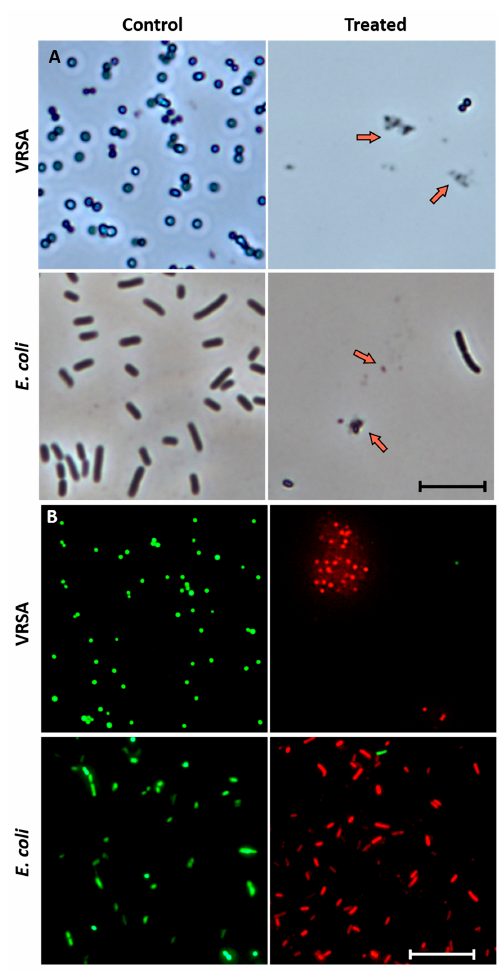
Figure 5. ( A ) The phase contrast microscopic images of VRSA and E. coli, with orange arrows showing the dead cells with cell debris. Scale is 5 µm. ( B ) The live/dead cell images of VRSA and E. coli, where cells stained with SYTO9 are live cells with green fluorescence and cells stained with PI are dead cells with red fluorescence. Scale is 10 µm. VRSA = Vancomycin Resistant Staphylococcus aureus .